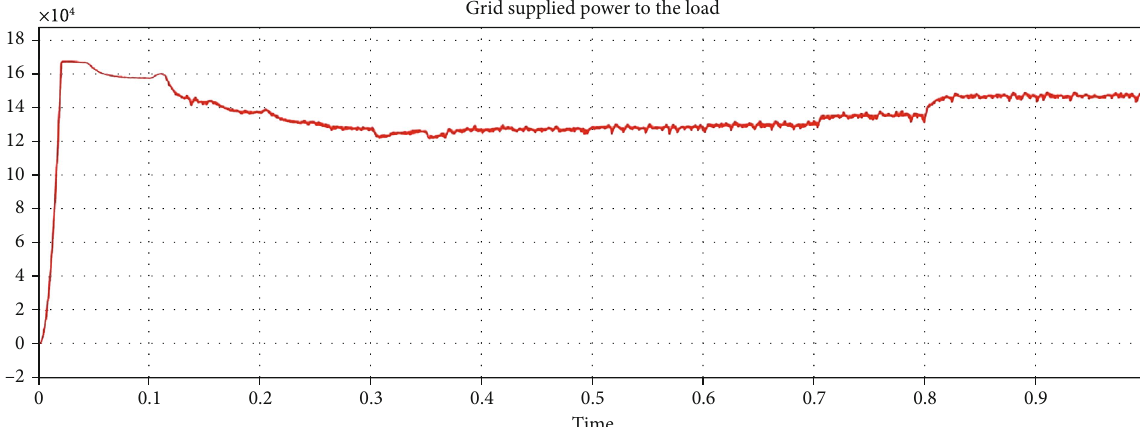
Figure 33: Grid power supplied to the load.